Question: Briefly state, in one sentence, what is plotted here.
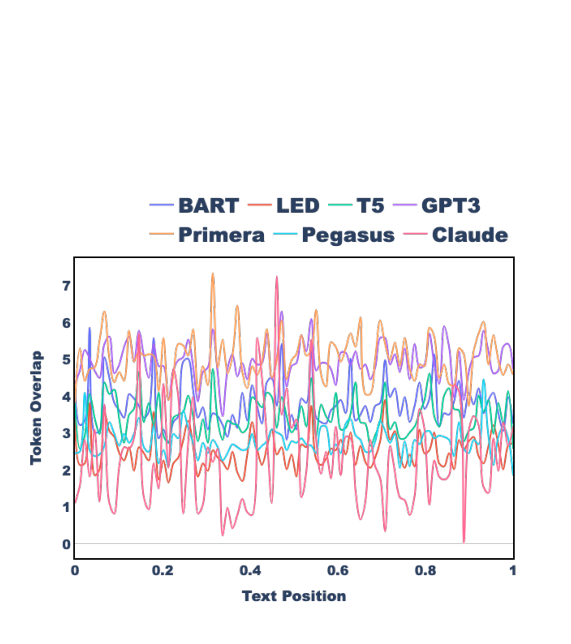
Answer: Average token overlap between ordered system-generated summaries by each abstractive sum- marization model and each document di in the input set D of DivSumm. Text position on the x-axis has been normalized between 0 and 1.